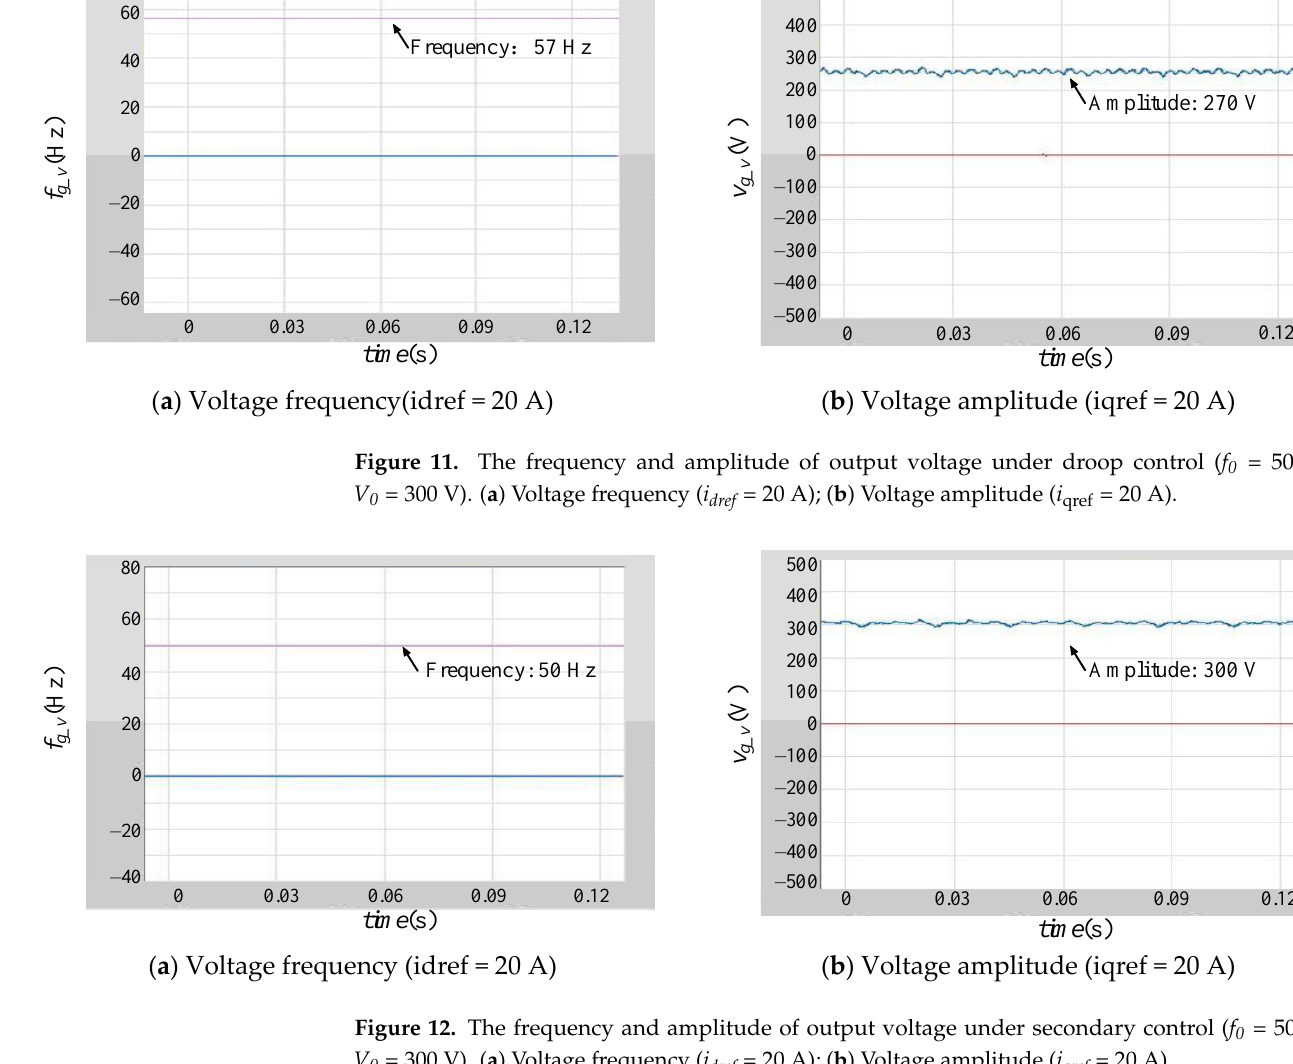
Figure 10. The output current of two converters under master-slave control (load is 150 Ω). ( a ) Con- verter-side current of voltage-controlled converter; ( b ) Grid-side current of current-controlled con- verter. 4.4. Hierarchical Control The testing and teaching of hierarchical control can be achieved by adjusting the con- trol schemes in the voltage-controlled converter. The current-controlled converter is con- sidered a constant power load in this type of testing and teaching. The active power can be regulated by adjusting the d-axis current reference and the reactive power can be reg- ulated by adjusting the q-axis current reference. First, only the droop control is implemented in the voltage-controlled converter. The